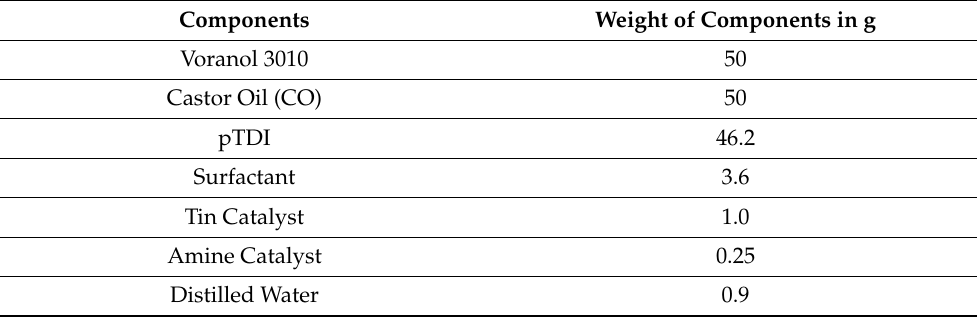
Table 1. Chemical composition of CO-based flexible polyurethane foam.